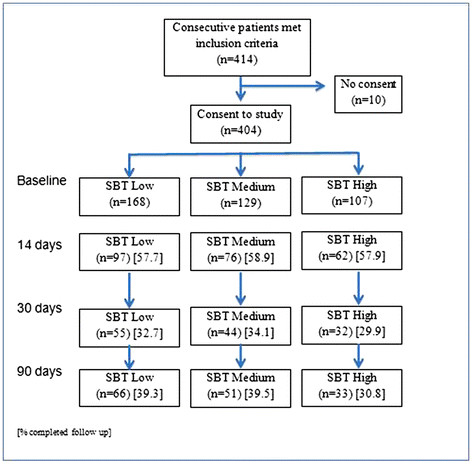
Numbers in study at each follow up point in each Start Back Tool category.